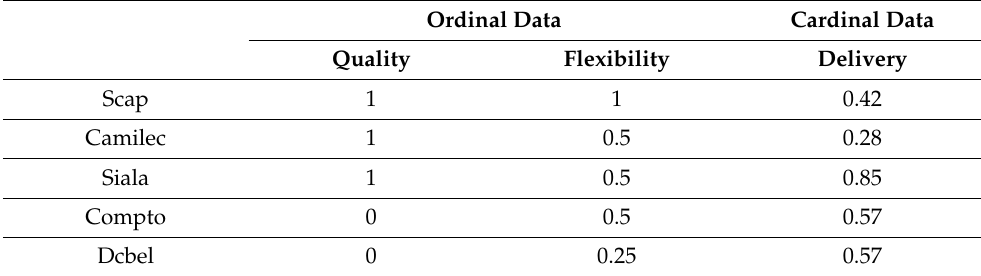
Table 6. The Meaningful Normalized Matrix for the Ordinal and Cardinal Data.